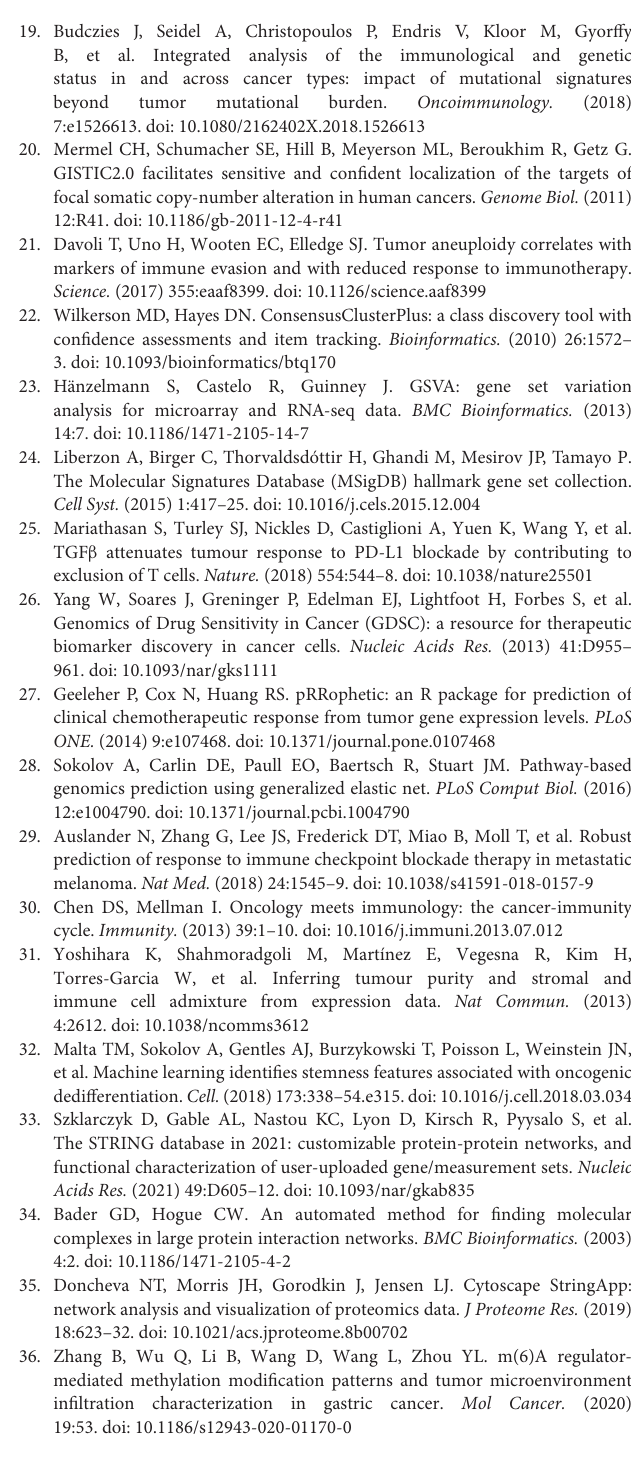
Supplementary Table 2 | The list of aging-relevant genes. Supplementary Table 3 | The list of 312 genes in the brown